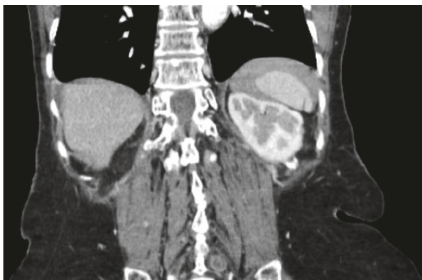
Figure 5: Repeat CT of abdomen and pelvis with contrast revealing an apparent linear defect measuring 0.9 cm involving the posteroinferior margin of the spleen. Again seen, consistent with prior study is the presence of a moderate amount of hyperdense free intraperitoneal fluid, indicative of